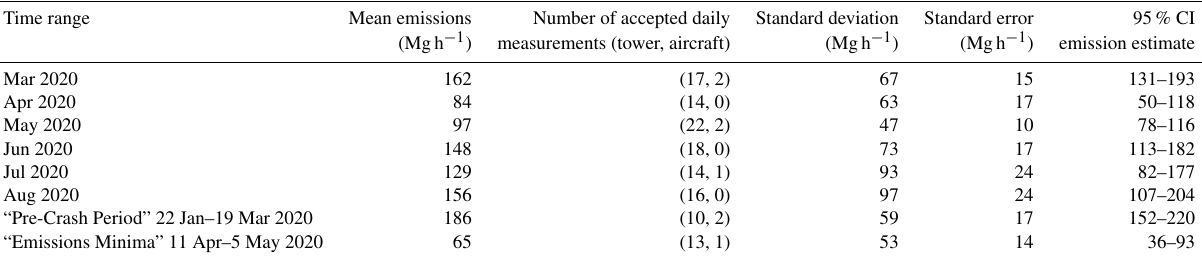
Figure 4. Tower and aerial emission estimates from the 100km × 100km study area through 31 August 2020. Individual daily accepted estimates from the tower observations are shown in green diamonds, while red circles with error bars represent the aerial estimate and 95% CI (confidence interval) range. The blue line represents the 7-data-point moving average of the tower estimates and the light blue shading shows the 95% CI range expressed as twice the 7-data-point moving standard error. The orange line represents the monthly average estimate from the combination of aerial and tower-based methods which weights tower and aircraft-based estimates equally. Table 1. Numerical estimates of CH 4 flux from the 100km × 100km study area derived from the combination of tower and aerial measure- ments across several temporal